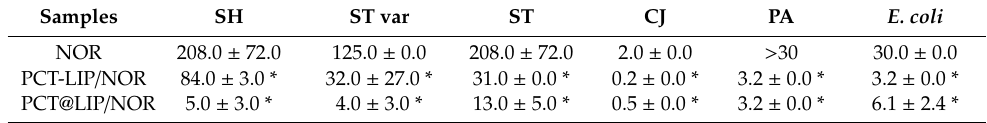
Table 1. Determination of the minimum inhibitory concentration (MIC, μ g/mL) for NOR (in